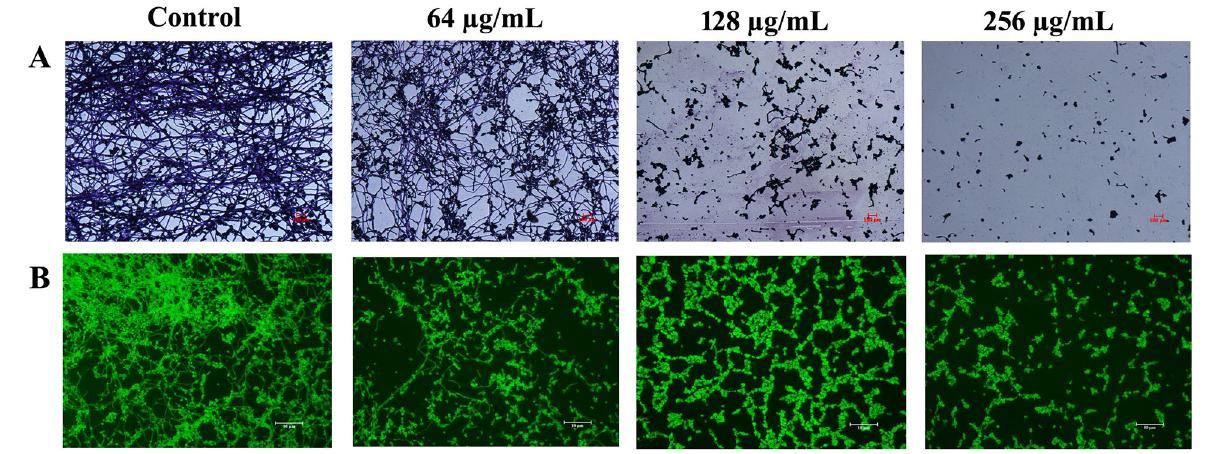
Figure 5. Microscopic visualization of C. albicans biofilms formed on the glass surface after 48 h of incubation at 37° C and subsequent staining with 0.1% acridine orange or 0.4% of crystal violet. ( A ) Light (×200 magnification) ( B ) Fluorescence micrograph of control samples showed tightly packed biofilms architectures surrounded with both yeast and hyphal cells. While, the micrograph of catechol treated samples depicted that